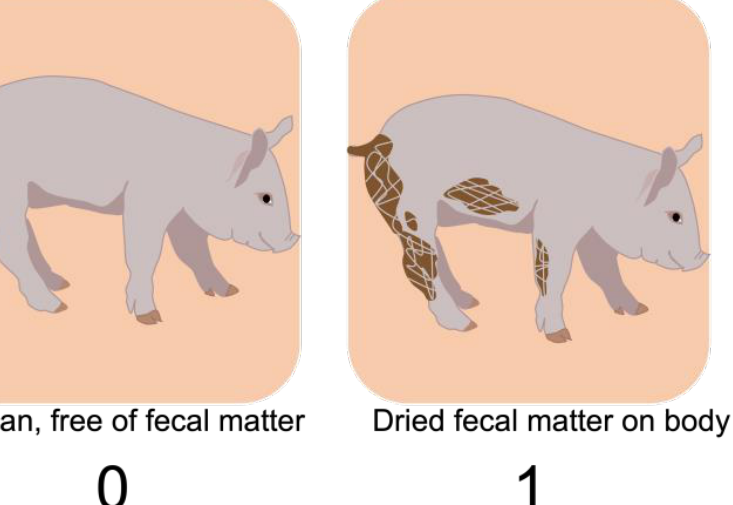
Figure 3. Human data: Posture and alertness categories and scores used by trained observers to classify pigs according to their clinical signs. Humans collected data for each pig in a pen, while standing in front of the pen for 3 min.